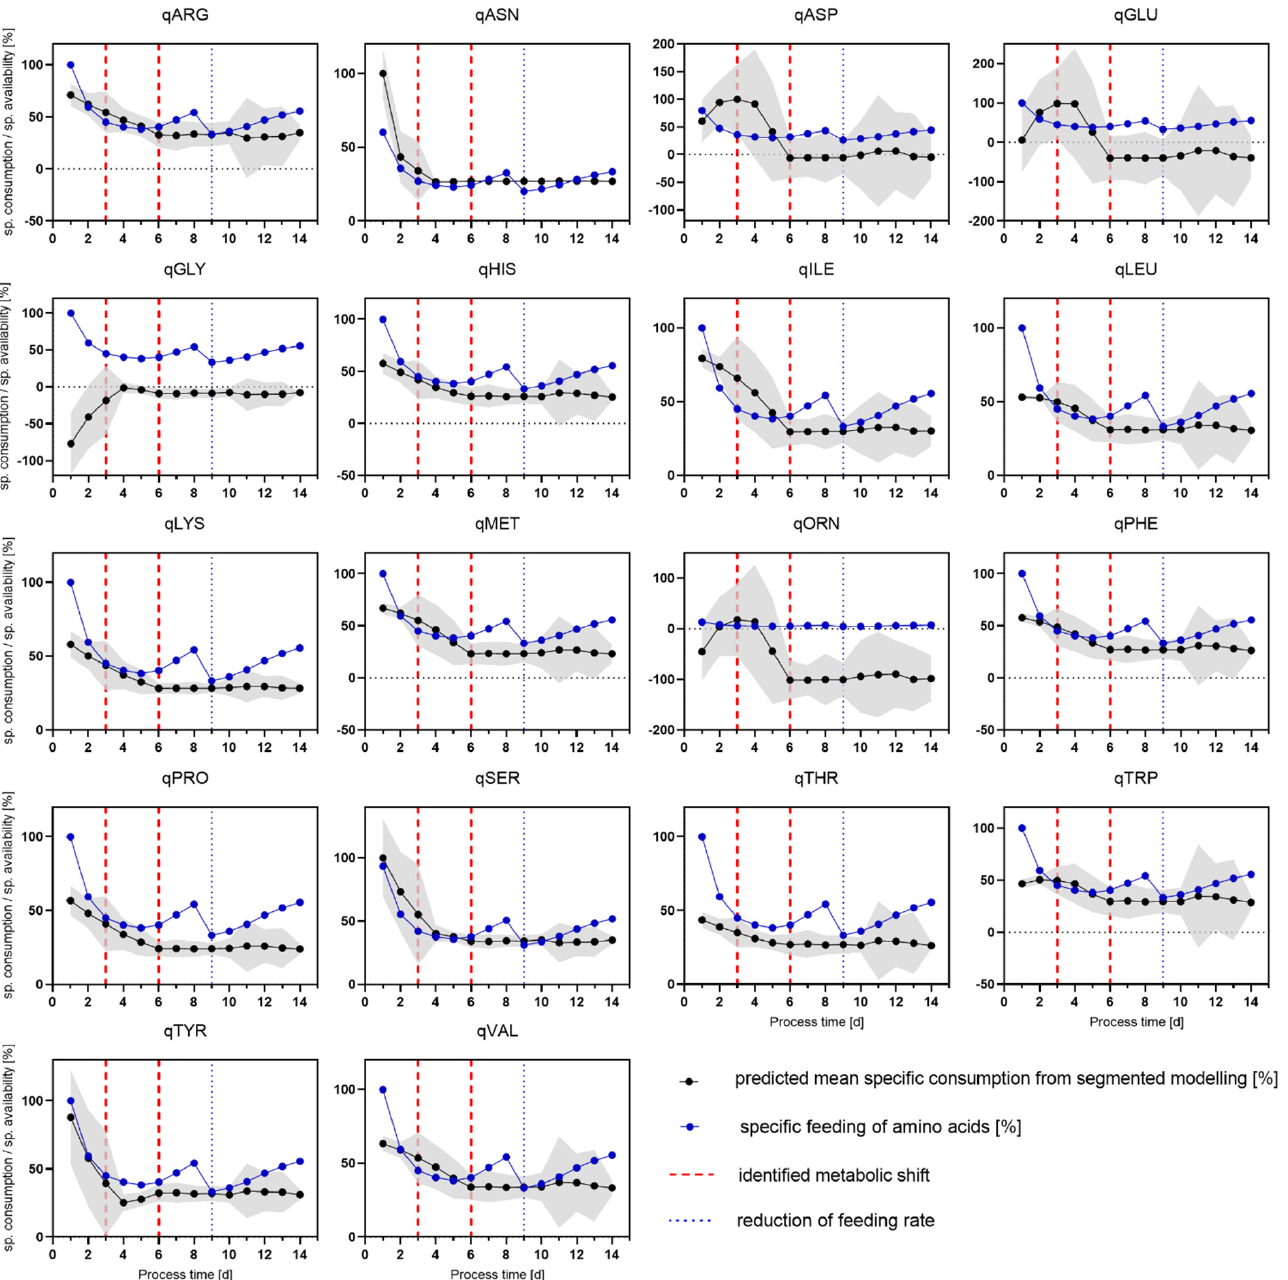
Figure 8. Comparison of predicted mean specific consumption from segmented modeling (average model which comprised three different HSD processes) with the specific feeding of amino acids. The identified metabolic shifts are depicted in red and the reduction in the feeding rate is shown in blue.